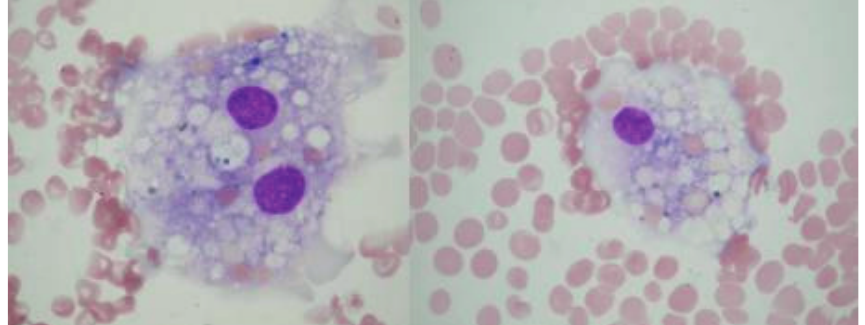
Figure 2: The bone marrow aspiration revealing active hemophagocytosis with prominent mature histiocyte phagocytosis of red blood cells (May-Giemsa stain, ×